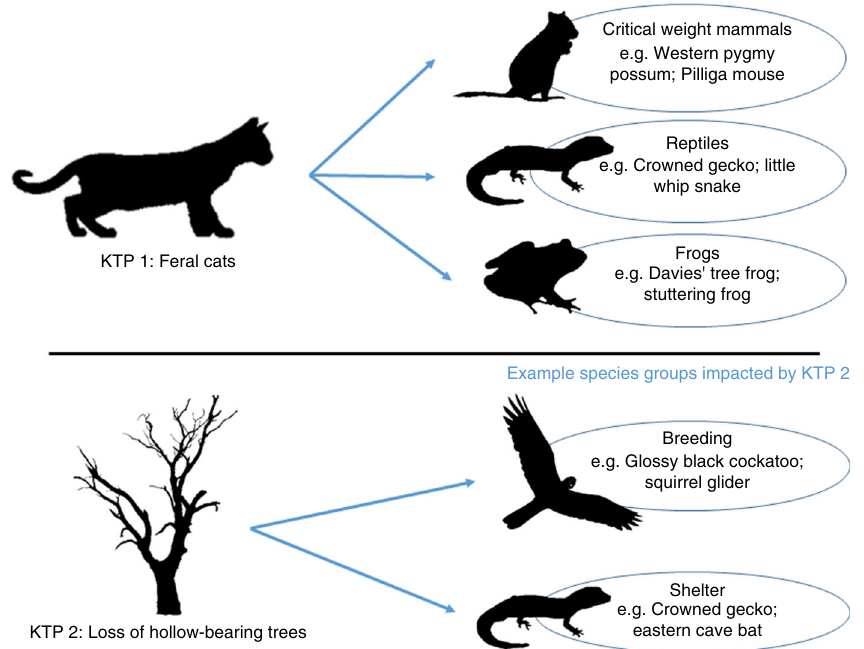
Fig. 8 Schematic illustrating the relationship between KTPs, species groups and species for two example KTPs. Species groups are composed of species, which are impacted similarly by a particular KTP. Note that not all KTPs, species groups or species are shown in the schematic